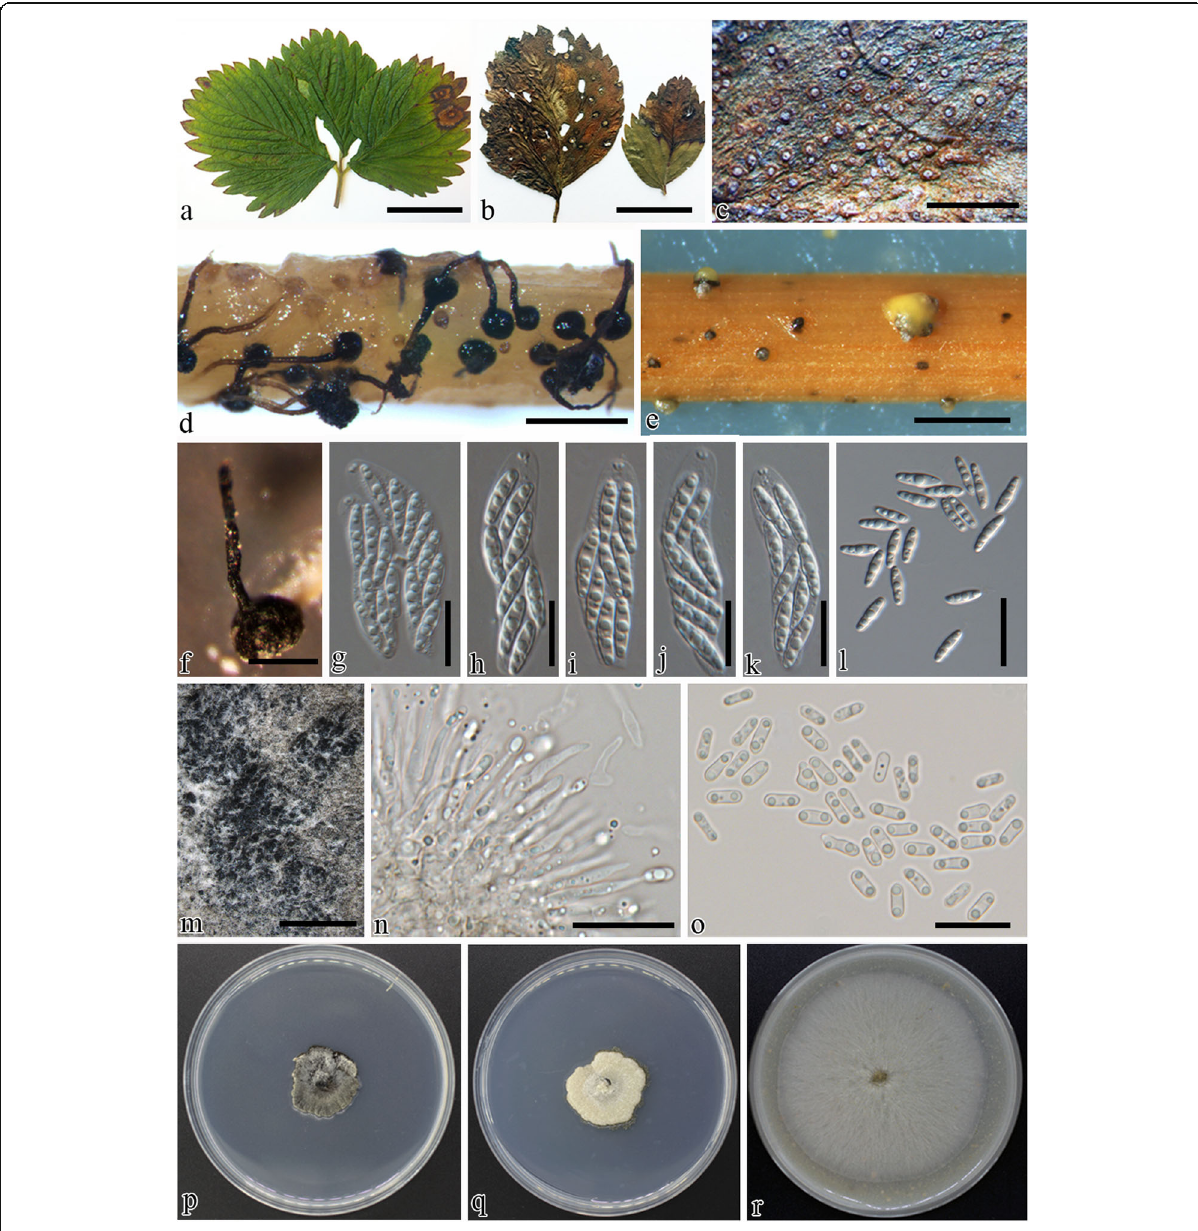
Fig. 3 Morphology of Gnomoniopsis fragariae (BPI 877447, CBS 121226). a,b Infected leaves of Fragaria sp.. c Pycnidia on leaf surface. d Perithecia on alfalfa stems on WA. e Pycnidia on alfalfa stems on WA. f Single perithecium on WA. g – k Asci l Ascospores. m Pycnidia on culture. n Conidiophores. o Conidia. p 7-d-old culture on PDA. q 7-d-old culture on MEA. r 7-d-old culture on V8A. Scale bars: a,b = 3 cm, c = 300 μ m, d,e